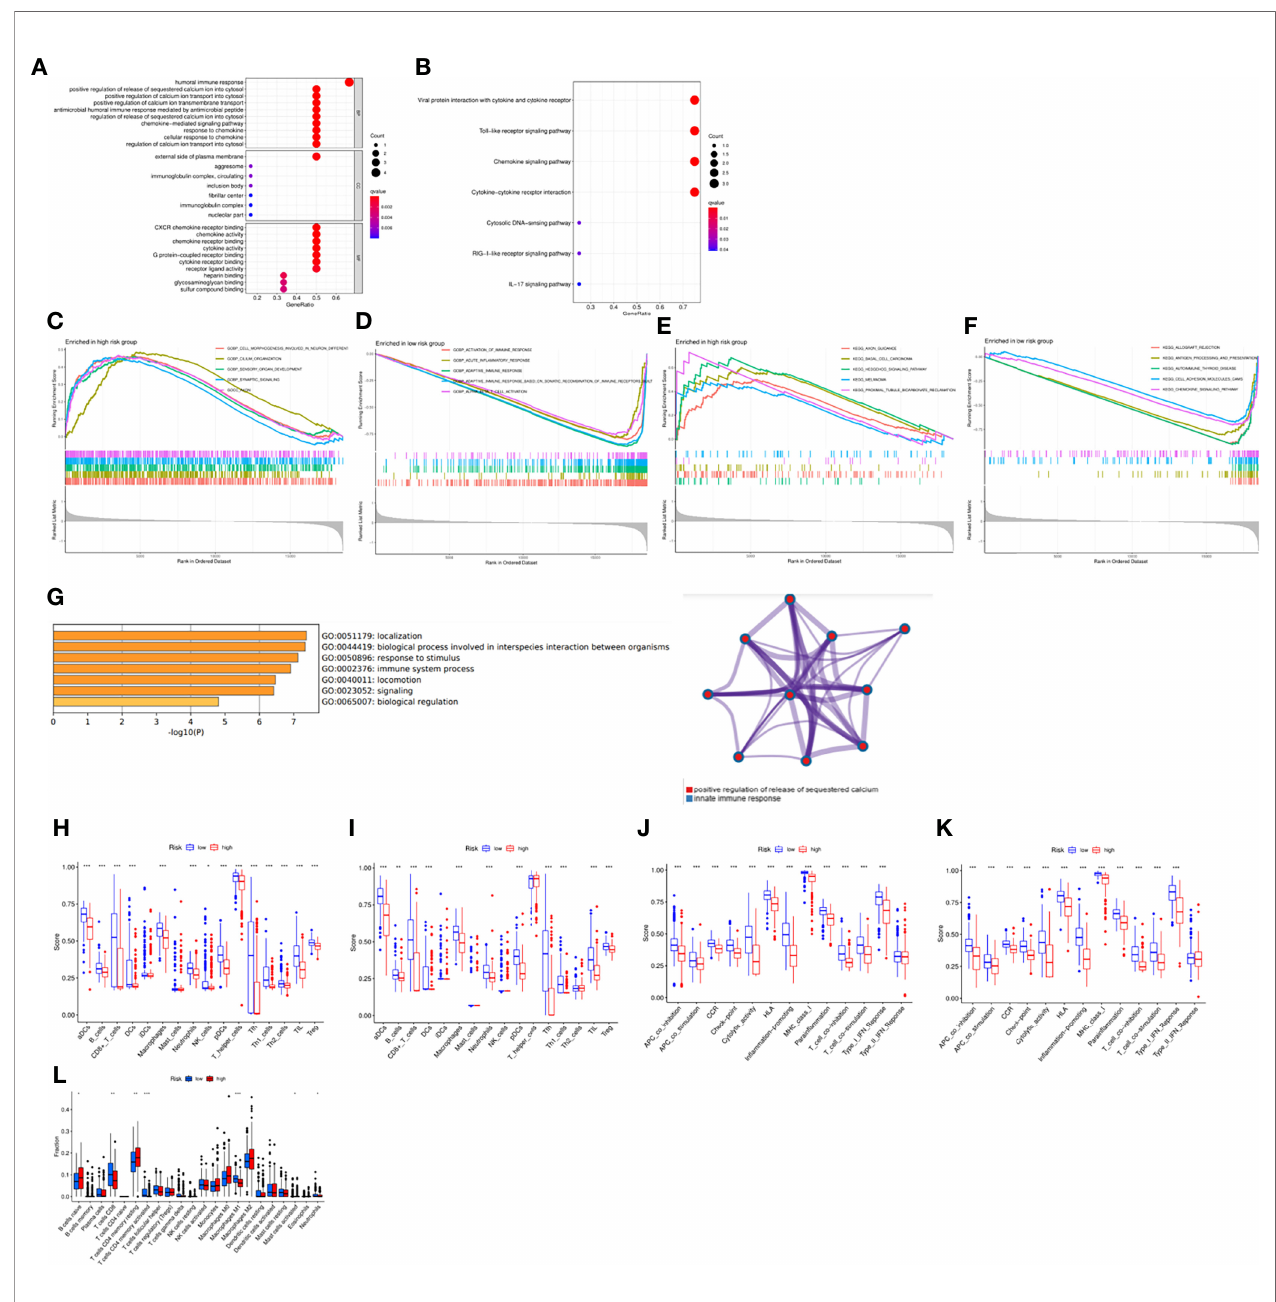
FIGURE 5 | Functional analysis based on the DEGs between the two-risk groups in the TCGA cohort. (A) GO enrichment analysis. (B) KEGG pathways enrichment analysis. (C – F) GSEA analysis of the DEGs. (G) Functional analysis via “ Metascape ” website. (H – K) The abundance of the immune cells and functions between groups via ssGSEA. (L) Comparison of the enrichment of the immune cells via CIBERSORT. * P < 0.05, ** P < 0.01 and *** P <